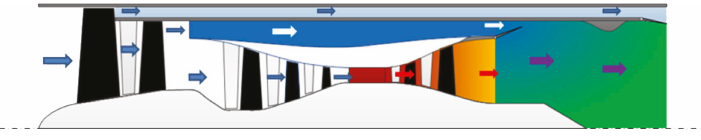
Figure 4: Flow path fi gure of three-stream ACE.